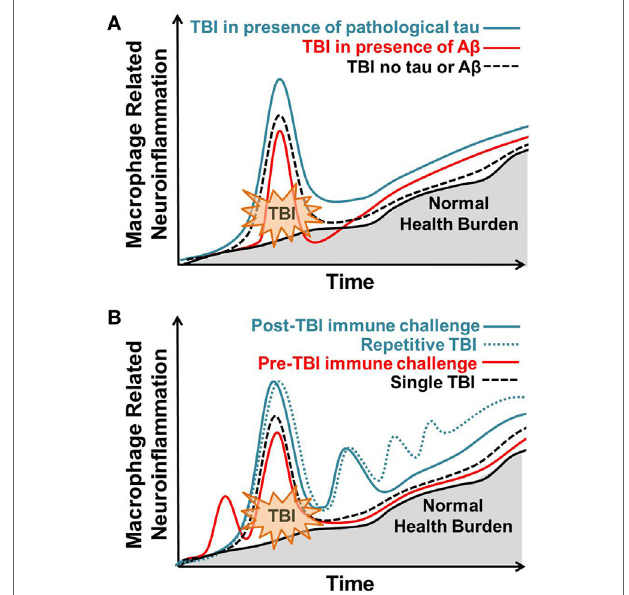
FiGURe 1 | Macrophage-related response to brain injury varies in response to previous, coincident, and subsequent immune stressors. Normal, age-related health burden is depicted with a solid black line and gray shading. (A) Traumatic brain injury (TBI) in the presence of pathological tau (solid blue line) results in an enhanced macrophage response to TBI that remains elevated at chronic post-injury time points. TBI in the presence of A β (solid red line) results in an acute blunted macrophage response that increases at chronic post-injury time points. TBI occurring in the absence of tau or A β (dotted black line) results in acute macrophage-related neuroinflammation that subsides over time. (B) Post-injury peripheral immune challenge (solid blue line) causes a hyper-active macrophage response correlating with behavioral dysfunction. Repetitive post-injury immune challenge (dotted blue line), similar to what is observed in repetitive TBI, increases macrophage-related neuroinflammation and correlates with the advanced neuropathology. Pre-injury peripheral immune challenge at sub-threshold levels (red line) attenuates the post-injury macrophage-related inflammatory response to TBI. Single TBI (dotted black line) results in acute macrophage-related neuroinflammation that subsides over time. Over time, macrophage-related neuroinflammation increases with normal health